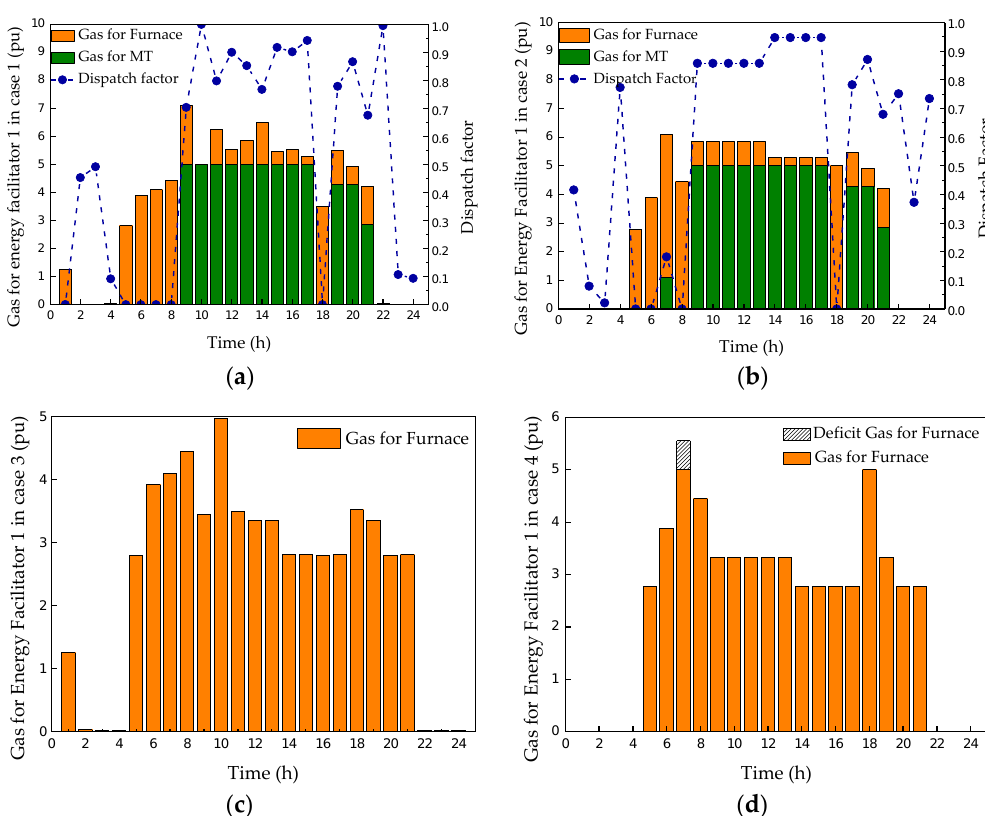
Figure 10. Gas supply from the natural gas network: ( a ) Case 1; ( b ) Case 2; ( c ) Case 3; ( d ) Case 4.